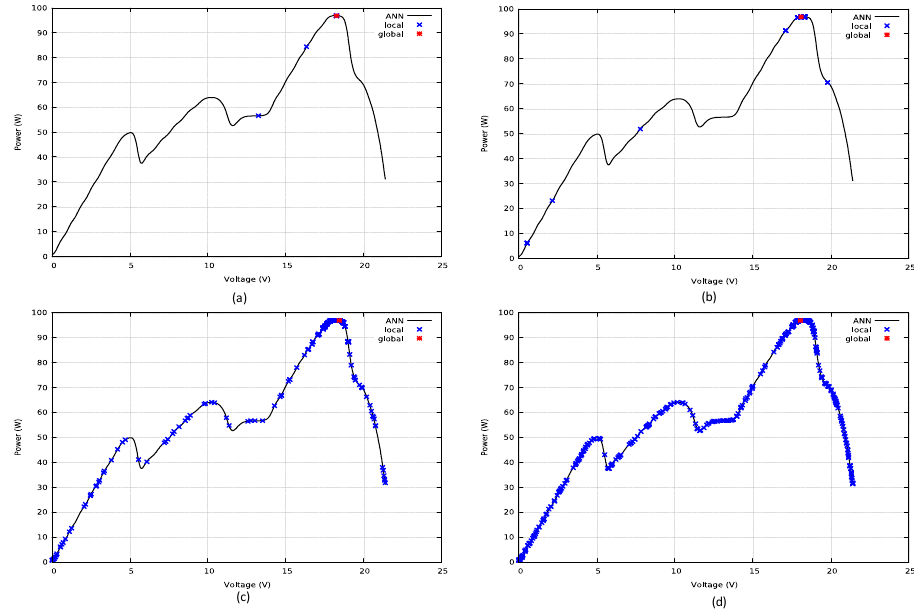
Figure 7. Results obtained with the algorithms for the test function 1: ( a ) GSS; ( b ) SA (T = 0.5); ( c ) SA (T = 100); ( d ) SA (T = 1000).